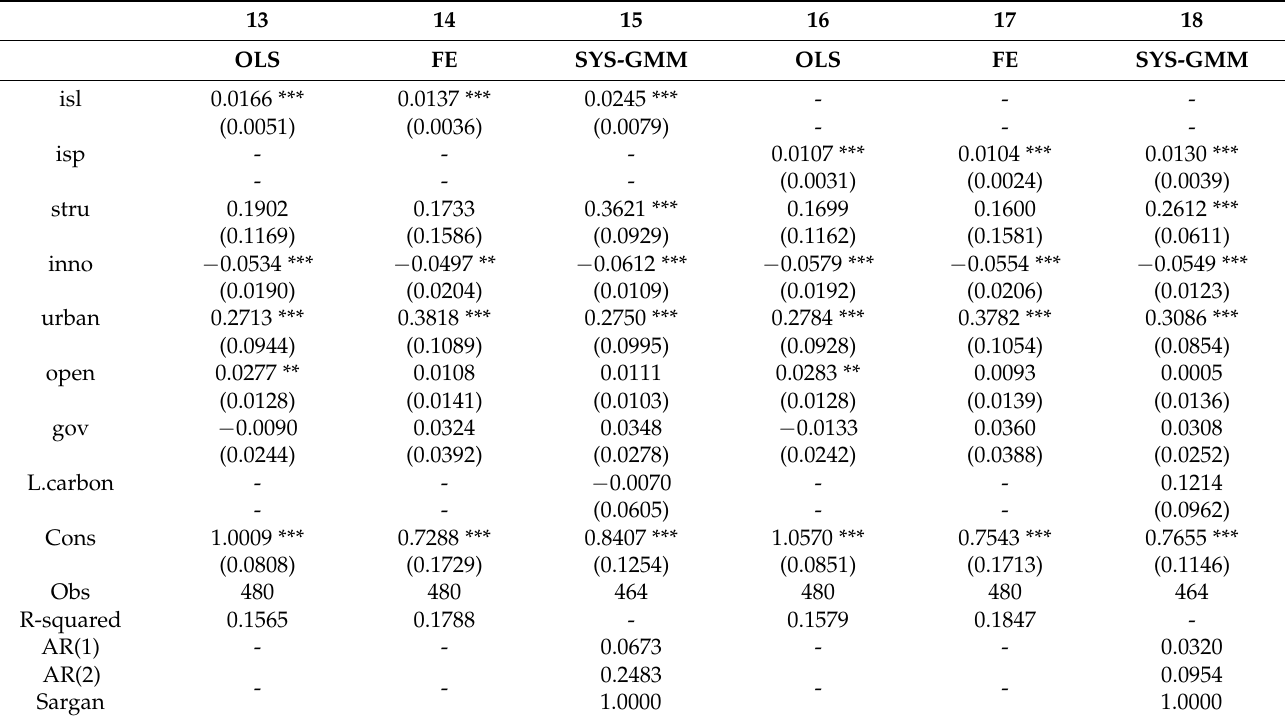
Table 4. Impacts of industry standard leadership and industry standard participation on carbon- emission